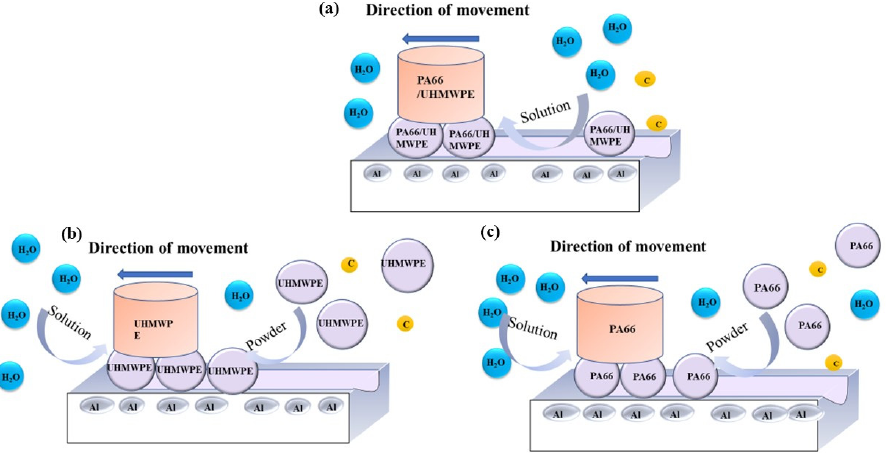
Figure 15. Suggested schematic diagram of lubrication layer formation. ( a ) UHMWPE/PA66 pins in water; ( b ) UHMWPE pins in water with powder in it; ( c ) PA66 pins in water with powder in it.